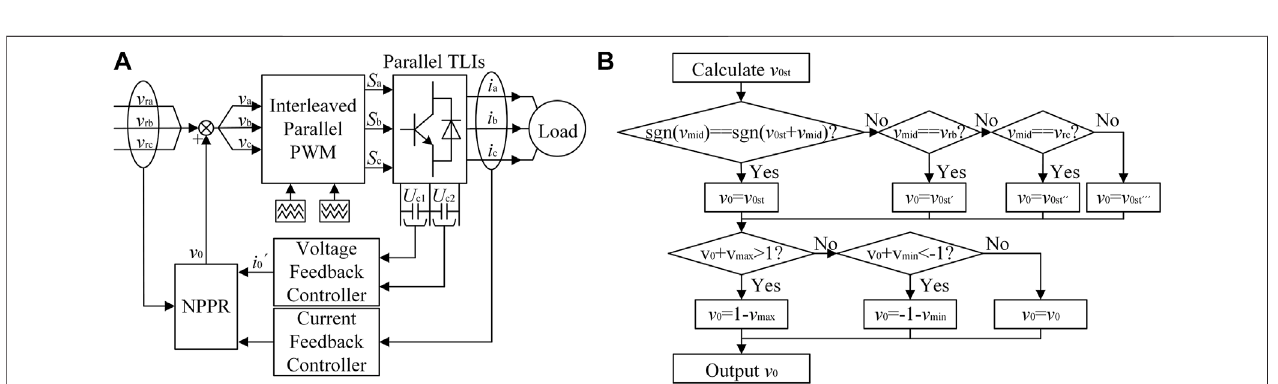
FIGURE 4 | Implementation of ZSVI: (A) block diagram, (B) fl owchart of NPPR.